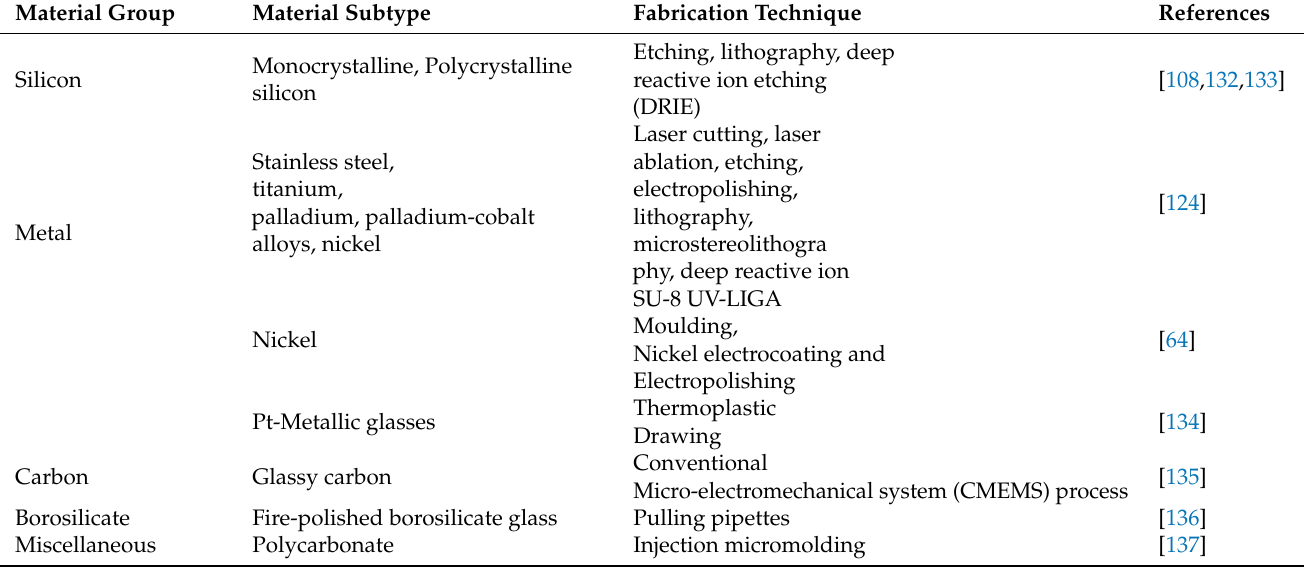
Table 3. Materials and fabrication technique of Hollow MNs (C á rcamo-Mart í nez et al.,